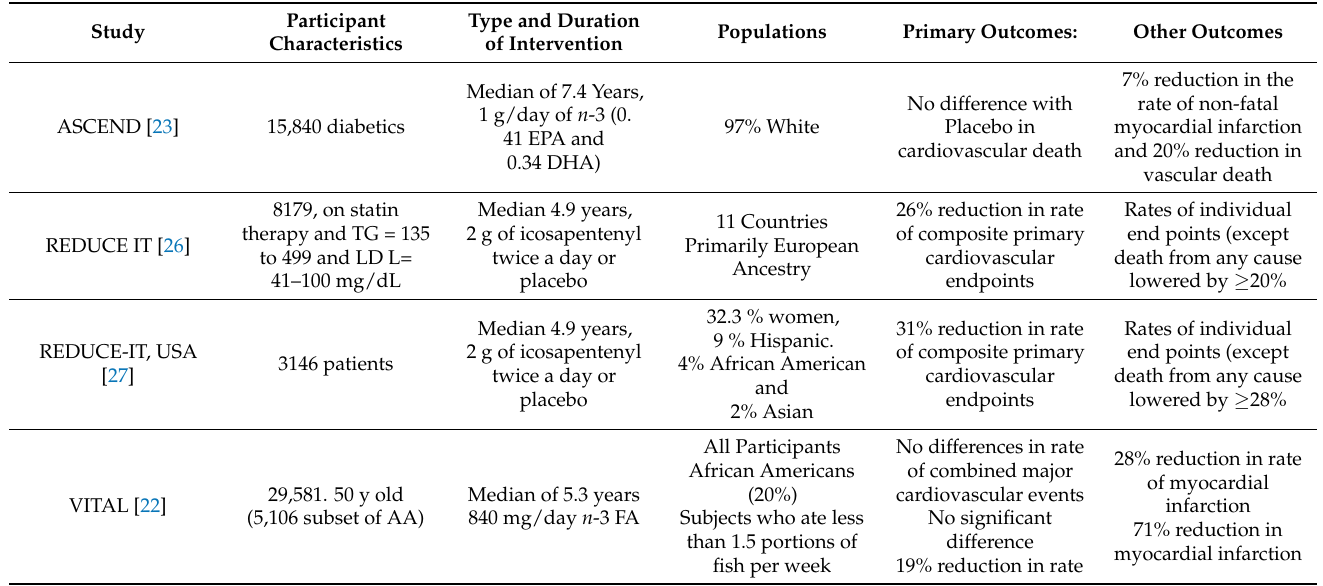
Table 1. Recent randomized, placebo-controlled studies of n -3 fatty acids (FA) in the prevention of cardiovascular disease *.